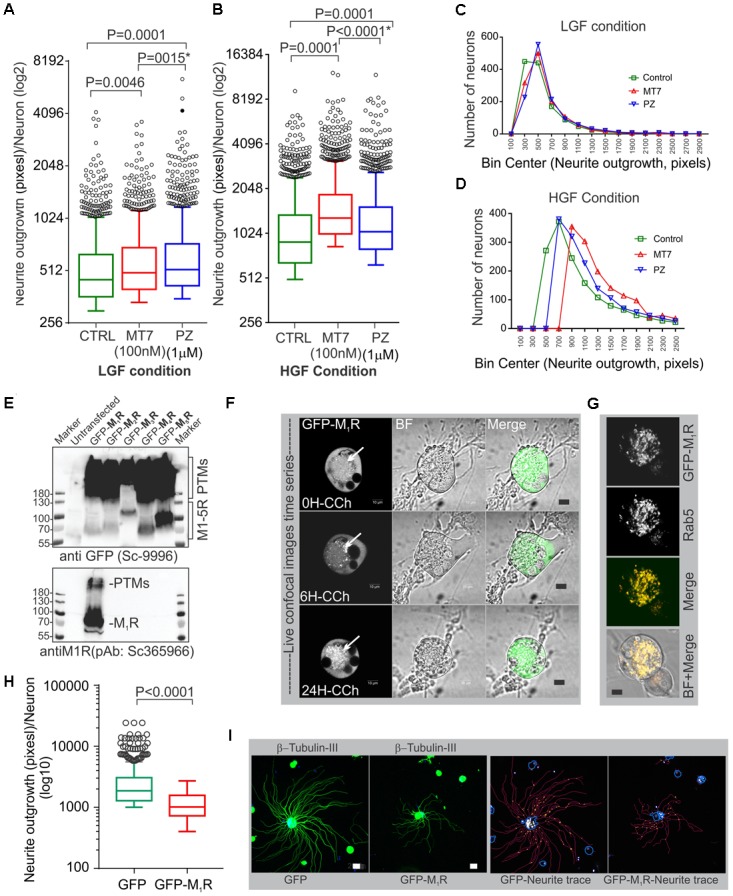
M1R antagonists, MT7 and pirenzepine, augment neurite outgrowth in primary sensory neurons and M1R overexpression inhibits neurite outgrowth. (A,B) Whiskers box (Tukey) showing total neurite outgrowth per neuron. Neurons were grown for 48 h in defined media containing LGF (A) or HGF (B) condition and treated with 100 nM MT7 or 1 μM pirenzepine (PZ), respectively. N = 1249 (LGF) and 1517 (HGF), respectively. P-values were calculated by one-way ANOVA followed by post hoc multiple comparison tests. Dunnett’s multiple comparisons test was used to compare the MT7 and PZ treatment groups with the control group and Sidak’s multiple comparisons test was used to compare between the MT7 and PZ treatment groups; ∗ indicates the p-value obtained by Sidak’s multiple comparisons test. (C,D) Binning of the entire data set presented in (A,B). (E) Immunoblot showing GFP-tagged muscarinic receptors (M1R to M5R) and GFP expression in transfected adult rat DRG neurons. pEGFP-C1-(M1R-M5R) plasmids were transfected in to DRG neurons and the lysate was resolved in SDS page and subsequently immunoblotted with anti-M1R (bottom panel) and anti-GFP (top panel) antibodies. (F) Time lapse confocal images showing increasing internalization (white arrows) of the GFP-M1R following treatment with carbachol (10 μM). Scale bar: 10 μm. (G) Immunofluorescence images showing colocalization of 24h CCh treated GFP-M1R with endosomal marker Rab5. Scale bar: 10 μm. (H) Whiskers box (Tukey) showing total neurite outgrowth per neuron, N = 634 (GFP), and N = 553 (GFP-M1R), neurons, respectively. P-value was calculated by t-test (unpaired). (I) Immunofluorescence images showing β-tubulin III staining and corresponding neurite trace (red lines) images in GFP and GFP-M1R overexpressed neurons. The total neurite outgrowth measurement was performed in Cellomics ArrayScan HCS Reader using neuronal profiling software. Scale bar: 10 μm.